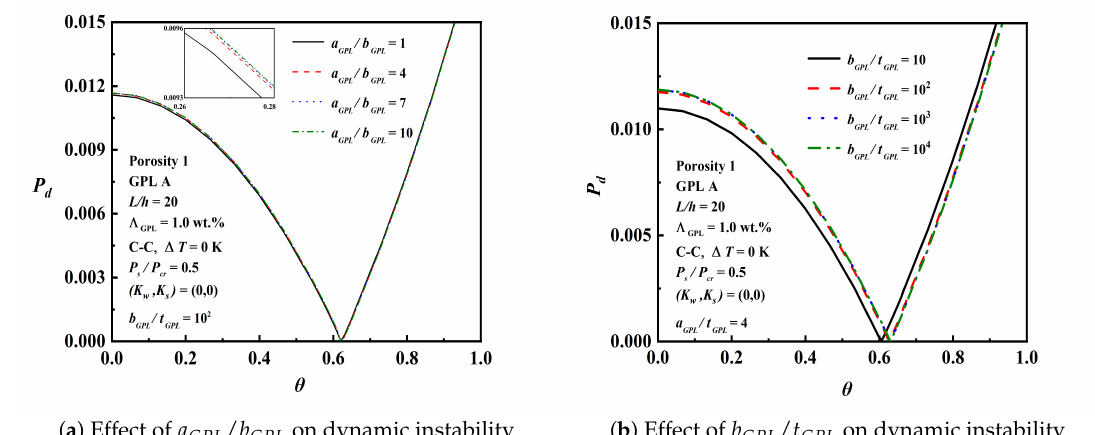
Figure 19. Effect of a GPL / b GPL and b GPL / t GPL on dynamic